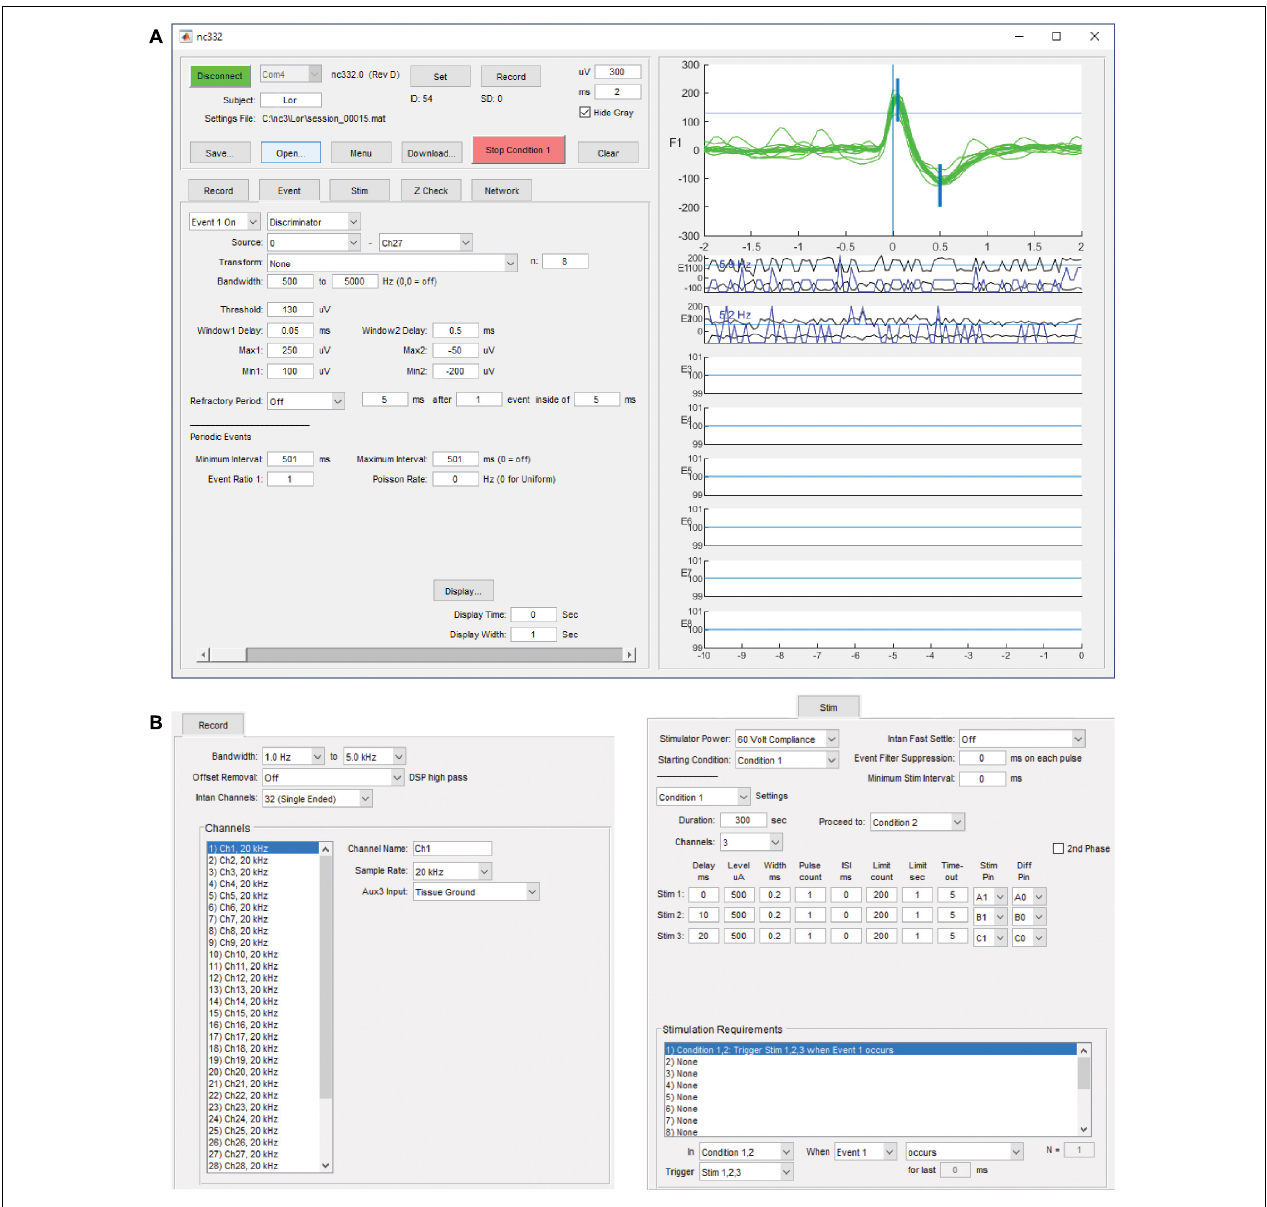
FIGURE 4 | Matlab-based graphical user interface on a PC. (A) Upper left panel contains controls for interacting with the NC3. Lower left tabbed panel contains settings for recording, event generation, spike discrimination, stimulation, impedance testing, and neural network simulation. Right panel shows data sweeps and summaries for checking performance and setting up correct event generation. It can also be used to review previously collected data. (B) Tabbed panels for record and stimulation